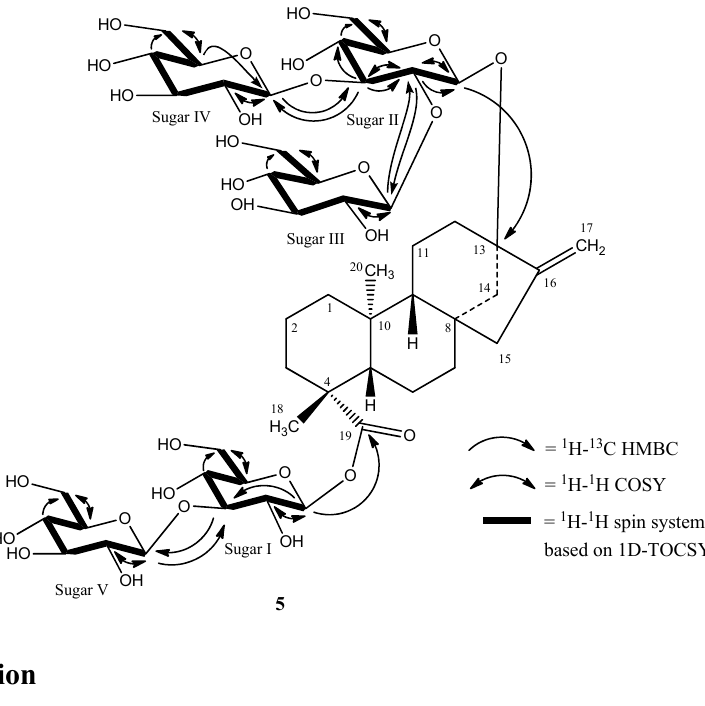
Figure 5. Key COSY, HMBC, and 1D-TOCSY correlations of rebaudioside I ( 5